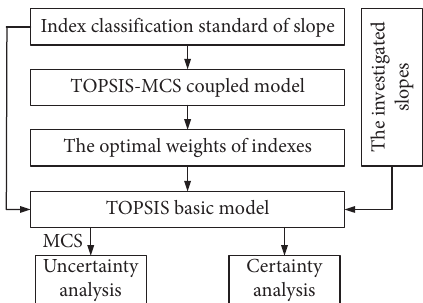
Figure 2: Basic flow chart for evaluating the slope stability with uncertainty and certainty analysis.